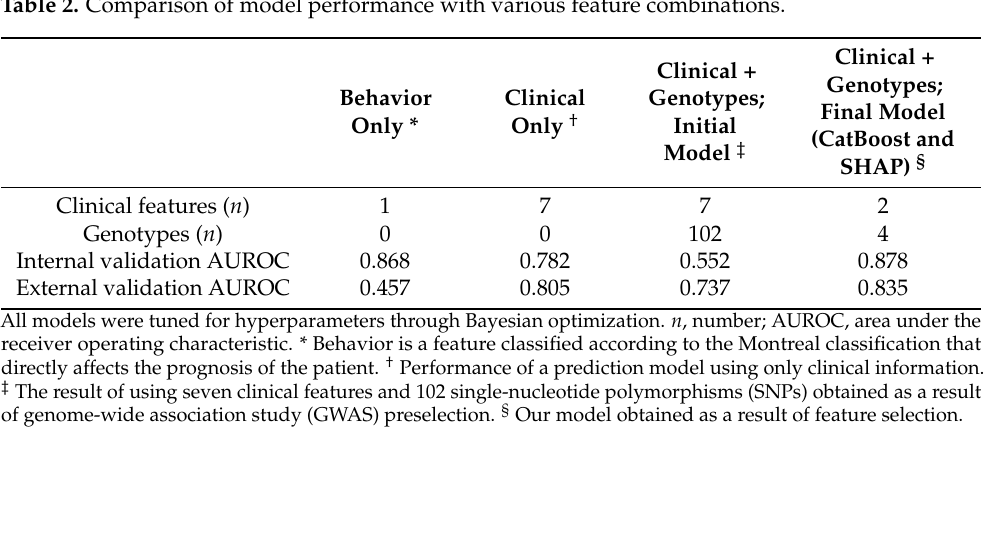
Figure 1. Shapley Additive Explanations (SHAP) summary plot by TreeSHAP. The features are shown in descending order of the mean absolute SHAP value on the Y -axis. Each dot represents a feature SHAP value of a patient. Categorical feature values are distinguished by color. Genotype and disease behavior are divided into three categorical features and represented by blue (major homozygote or noncomplicated), purple (heterozygote or stricturing), and red (minor homozygote or penetrating) colors. Age, a continuous variable, is represented by a color gradient from blue (young) to red (old). Features which are divided into two categories are represented by blue and red colors. ( A ) The final model comprising six clinical and genetic features. ( B ) The model based on seven clinical features only. Table 2. Comparison of model performance with various feature